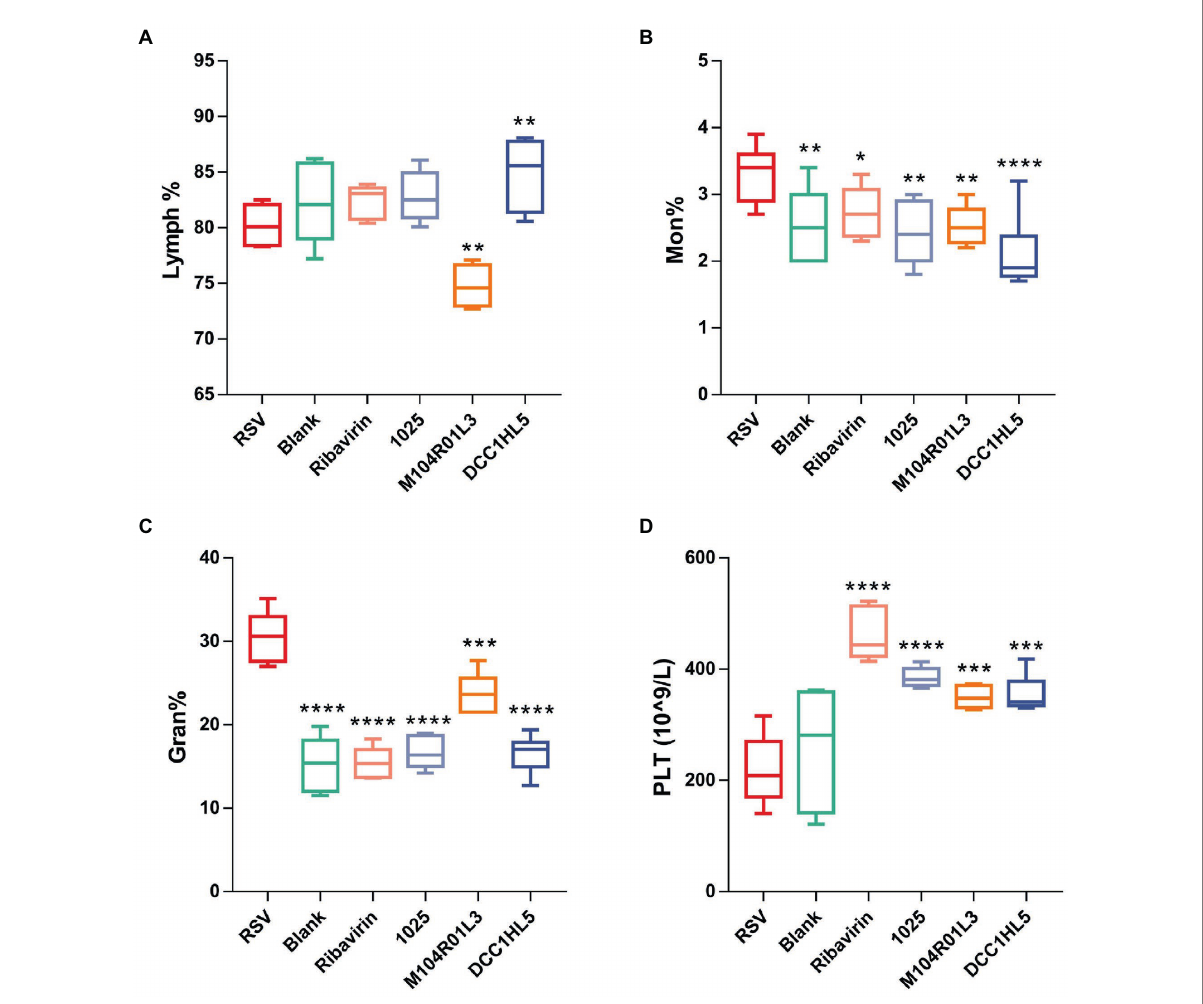
FIGURE 2 Changes in systemic immune responses. Proportions of (A) lymphocytes (Lymph%), (B) monocytes (Mon%), and (C) granulocytes (Gran%). (D) Platelets (PLTs) in blood ( n = 8; * p < 0.05, ** p < 0.01, *** p < 0.001, **** p < 0.0001 vs. RSV group). Differences were compared using one-way ANOVA, followed by Fisher’s LSD test. P -values were adjusted using false discovery rate. Blank, not infected with RSV. RSV, infected with respiratory syncytial virus and